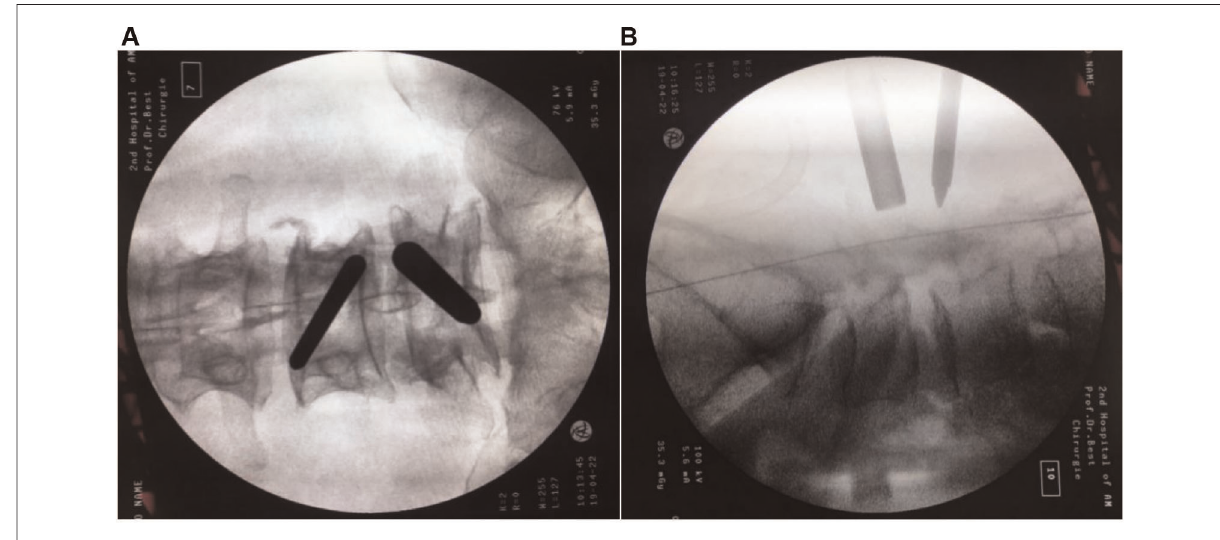
FIGURE 4 Intraoperative fl uoroscopic con fi rmation of metal rods. Triangulation of metal rods is done at the docking point (the medial of facet joint) under the C-arm: anteroposterior ( A ); and lateral views ( B